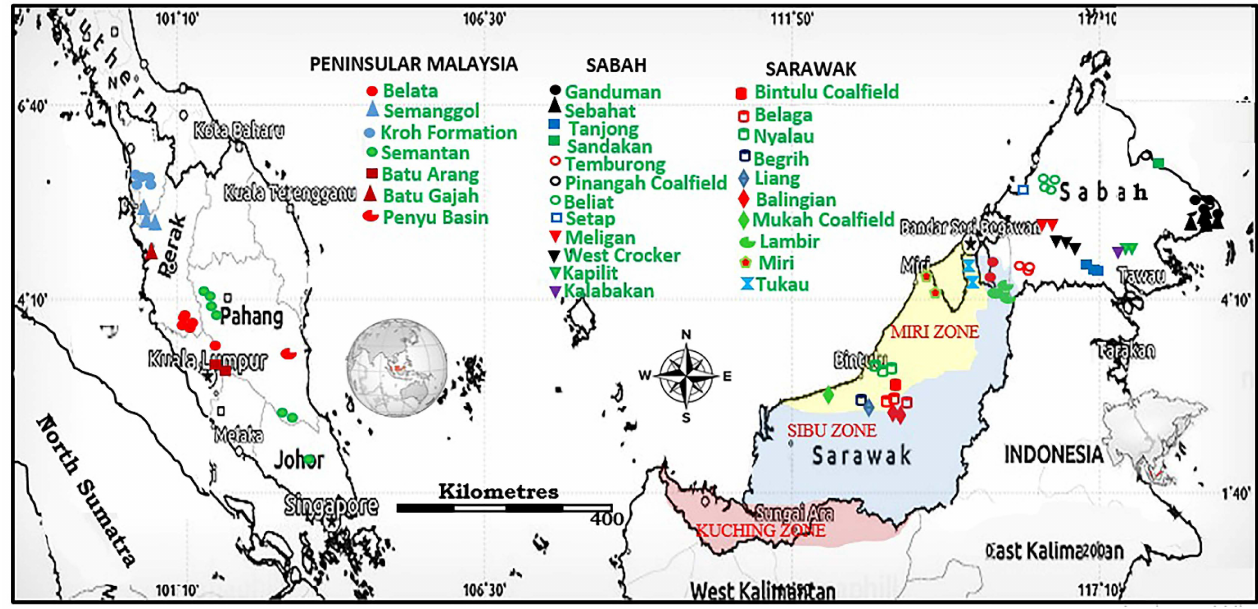
Figure 1. Map of Malaysia showing the locations of the formations analyzed in this